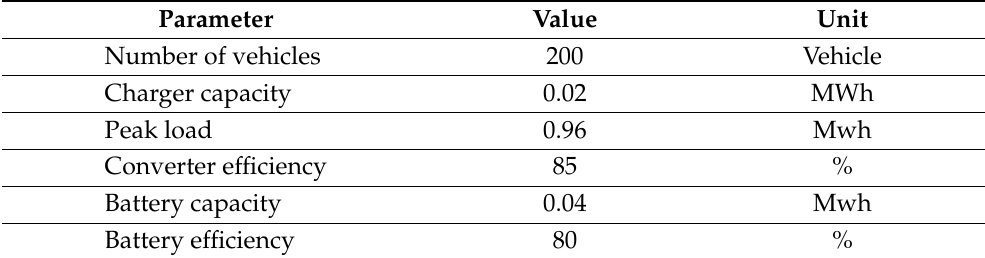
Figure 1. The system under study. Table 1. Microgrid technical